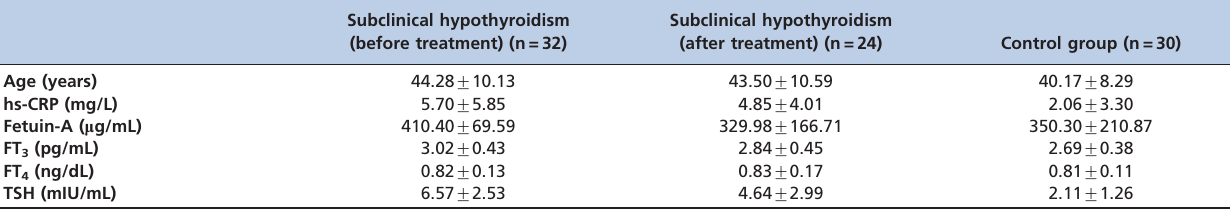
Table 1 - Demographic and clinical parameters in SHO patients and controls.